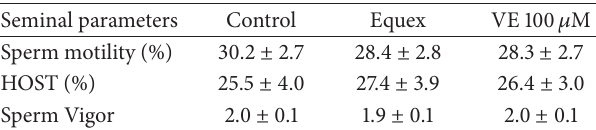
Table 3: Experimental design. Table4:Spermmotility,spermvigor,andhypoosmoticswellingtest (HOST) of thawed goat semen cryopreserved with different media (mean ± standard error of mean).